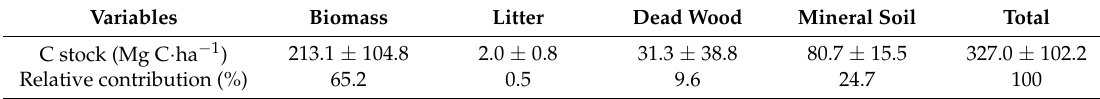
Table 3. Initial carbon (C) stocks and their relative contribution to the total forest C stock.